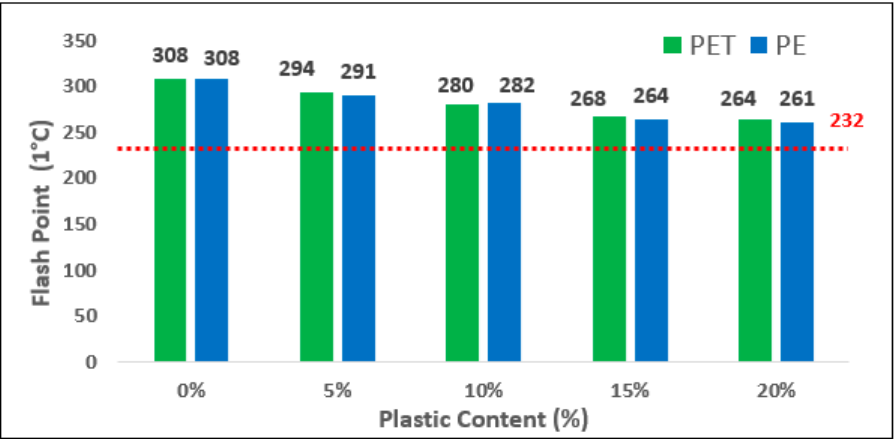
Figure 8. Flash Point of Modified Bitumen versus different Plastic contents .